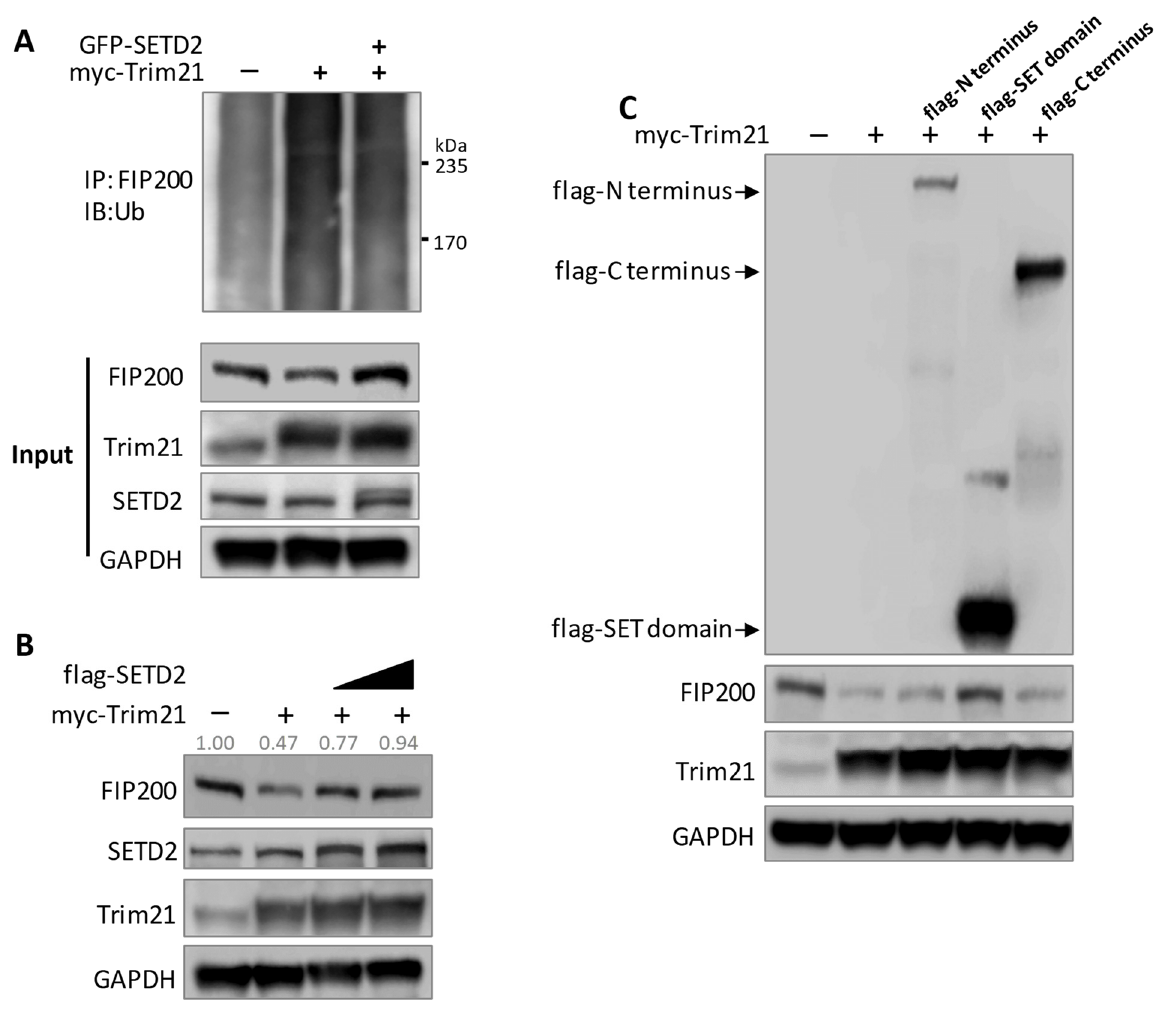
Figure 6. SETD2 reverses Trim21-mediated degradation of FIP200. ( A ) SETD2 overexpression reduced Trim21-mediated FIP200 ubiquitination. HeLa cells were transfected with His-Ub and indicated plasmids. ( B ) SETD2 prevented Trim21-induced FIP200 degradation in a dose-dependent manner. HEK293 cells were transfected with indicated plasmid. Protein levels of FIP200 were assessed by immunoblotting. FIP200 was quantified and normalized to GAPDH. ( C ) The SET domain of SETD2 diminished Trim21-induced FIP200 degradation. HEK293 cells were transfected with indicated plasmid expressing different SETD2 fragments. Immunoblot showed that only the SET domain stabilized the FIP200 protein.